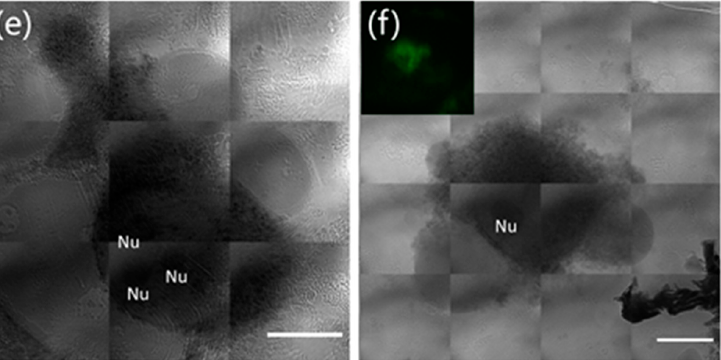
Figure 4. Fluorescent and soft X-ray mosaic images of HeLa cells. ( a - d ) HeLa cells treated with 0.5 μ M staurosporine for 4 hours. The inset is a fluorescent picture, corresponding to the mosaic. The intense fluorescence in ( a , b ) indicates apoptotic cells, while the faint fluorescence in ( c , d ) indicates that the cells are not apoptotic; ( e , f ) Normal HeLa cells without treatment. Nu indicates nucleolus. Scale bar 10 μ m.